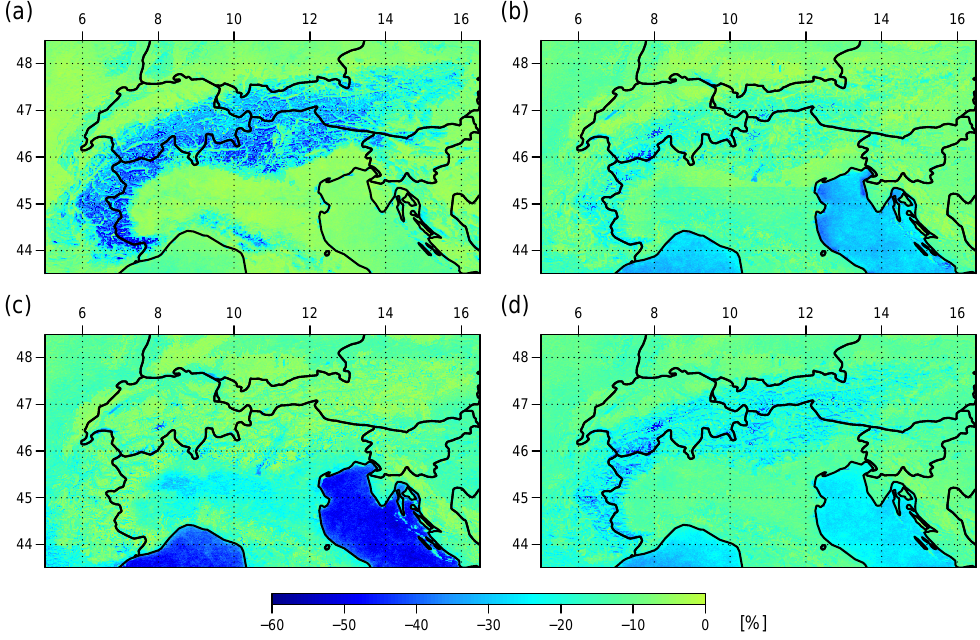
Figure 13. Effect of the model on cloud occurrences, in percent relative to the initial cloud occurrences. The results are averaged over MODIS-Aqua data set (2003–2014) by season: winter (a) , spring (b) , summer (c) , and autumn (d) . The seasons are defined as